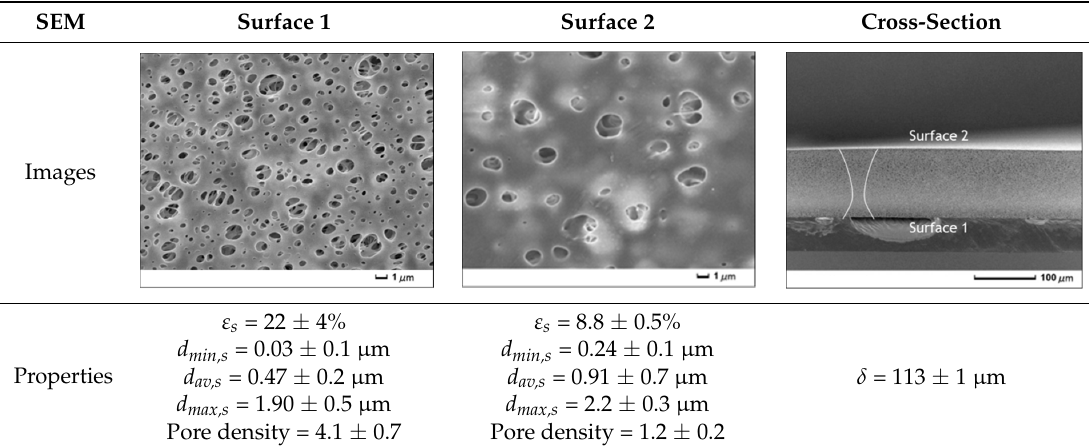
Table 3. Surface and cross-section images of the commercial polyethersulfone (PES) membrane and properties obtained using image analysis.